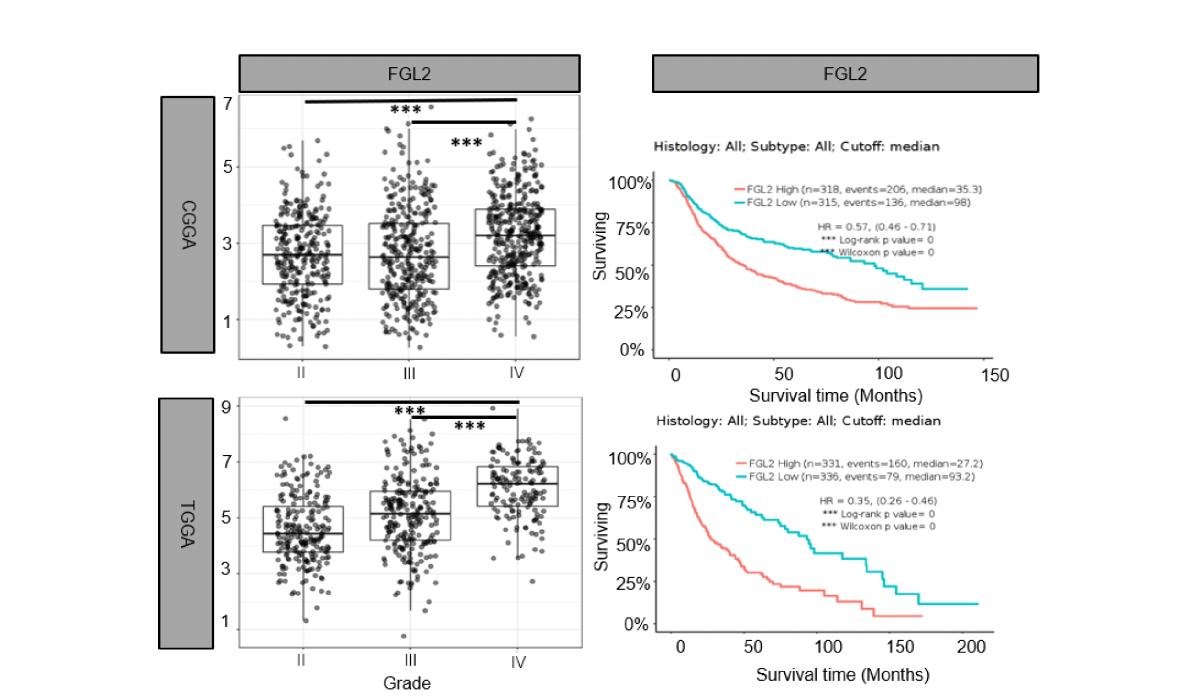
FIGURE 1 Elevated FGL2 mRNA levels in samples from patients with glioma and associated with poor patient prognosis. Analysis of glioma patient samples from The Chinese Glioma Genome Atlas (CCGA) and The Cancer Genome Atlas (TCGA) cohorts. FGL2 mRNA expression levels increased with glioma grade (II, III, IV). The fi gure was excerpted from GlioVis